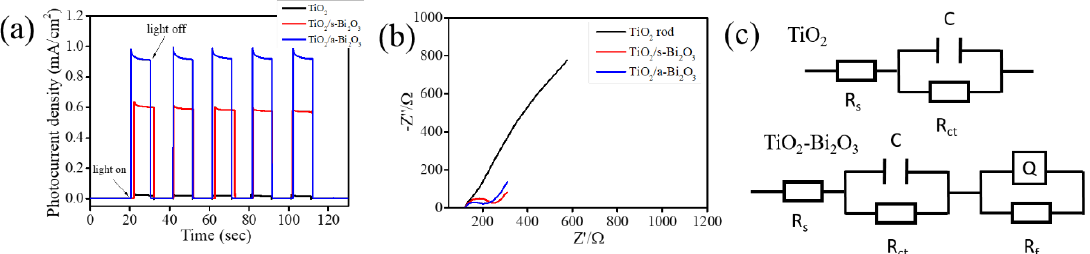
Figure 7. ( a ) Transient photocurrent density versus time curves of various rod samples under chopped irradiation at 1 V. ( b ) Nyquist plots of various rod samples under light irradiation. ( c ) The possible equivalent circuit used for R ct evaluation of various rod samples.